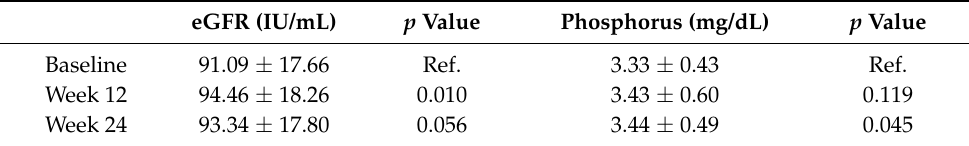
Table 3. Changes in renal function after TDO treatment during the study period.